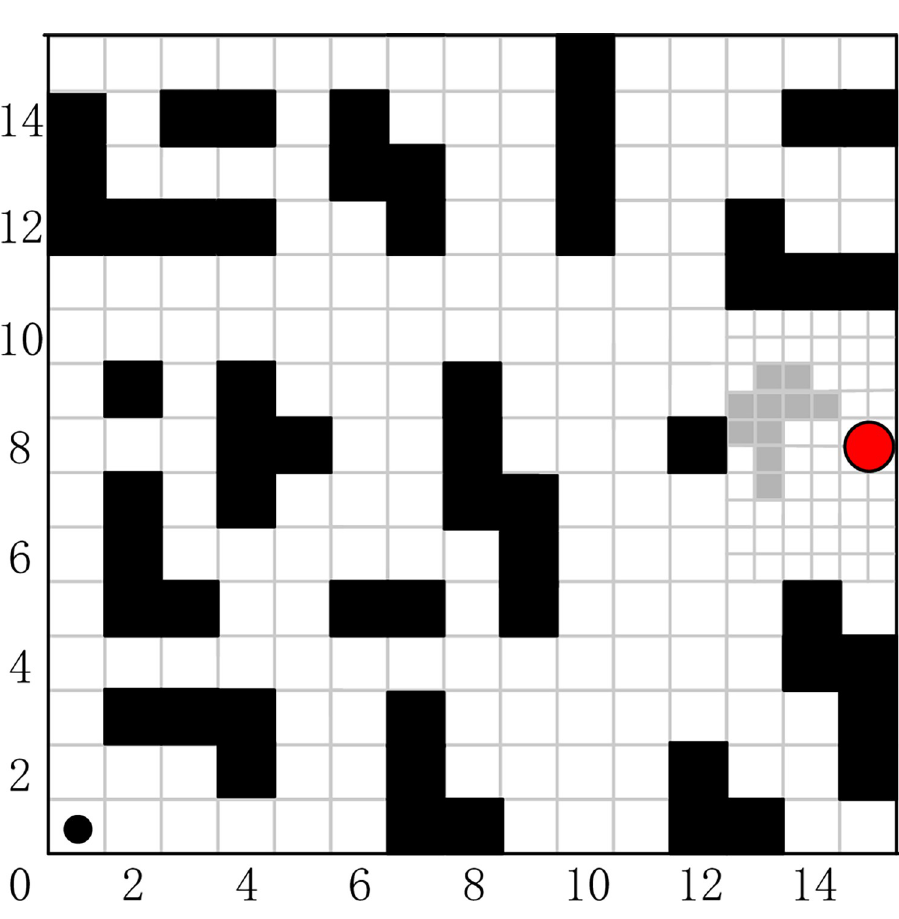
Fig 4. The improved grid